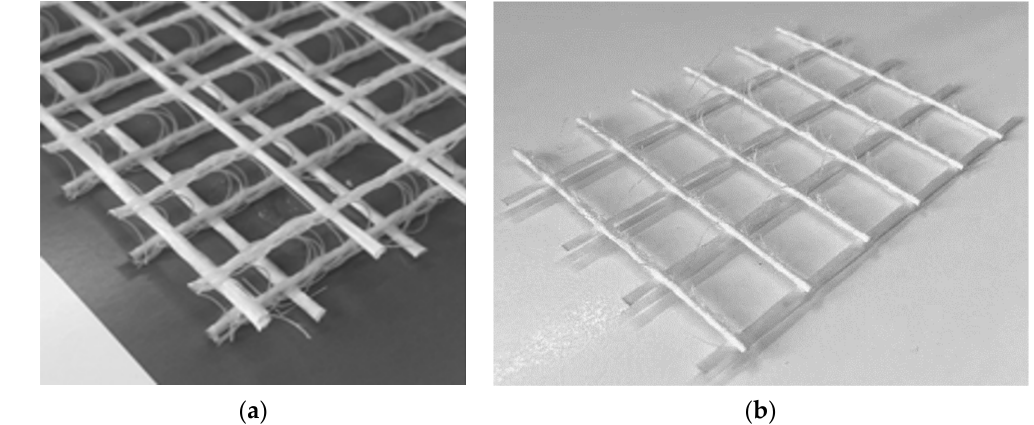
Figure 1. Images of: ( a ) the 3D glass textile; ( b ) the 2D equivalent textile. Table 1. Properties of the textile reinforcement, obtained from [27].